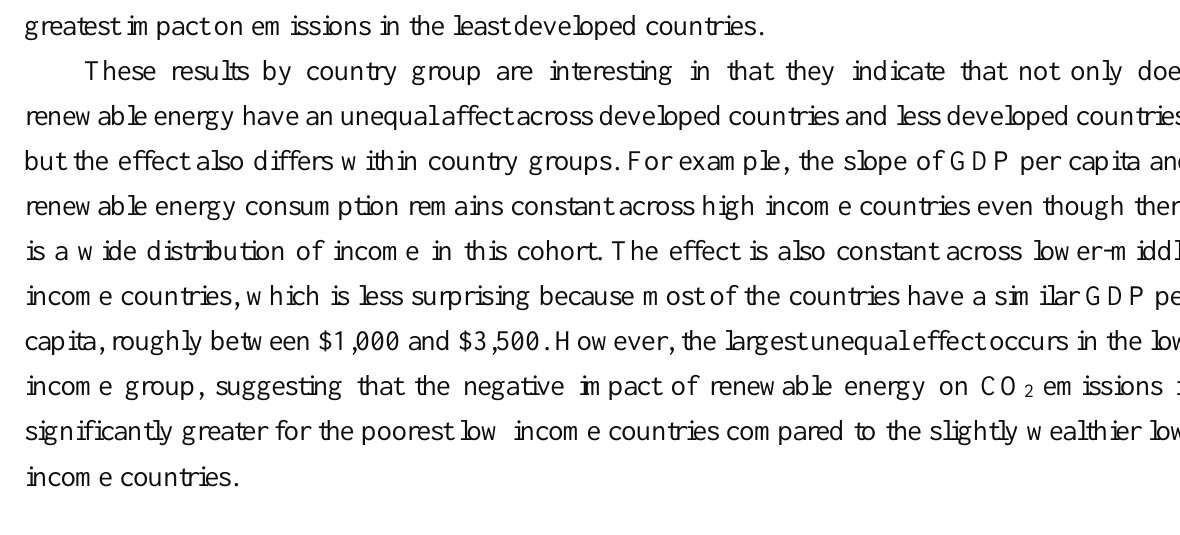
Table 3 . Slope Coefficients of GDP per Capita and Renewable Energy